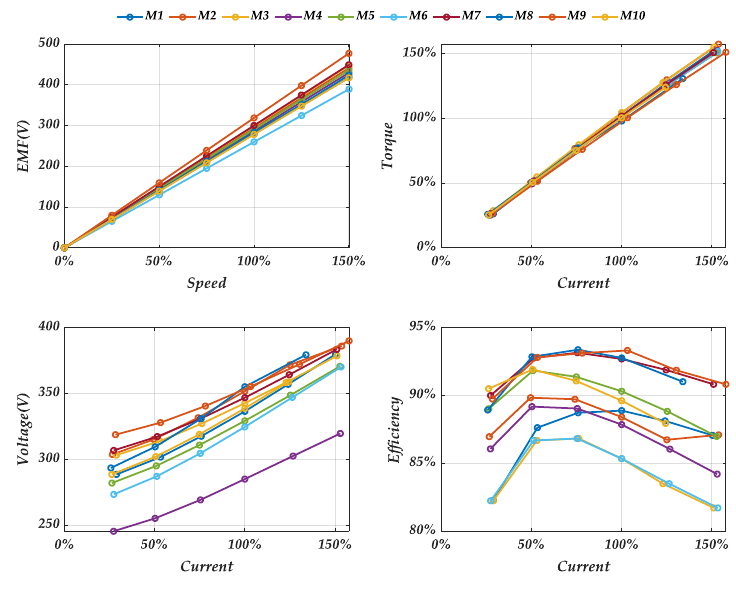
Figure 13. EMF, Torque, Voltage, and Efficiency vs. Current calculated by the Sizing Tool during the sizing process of 10 machines.